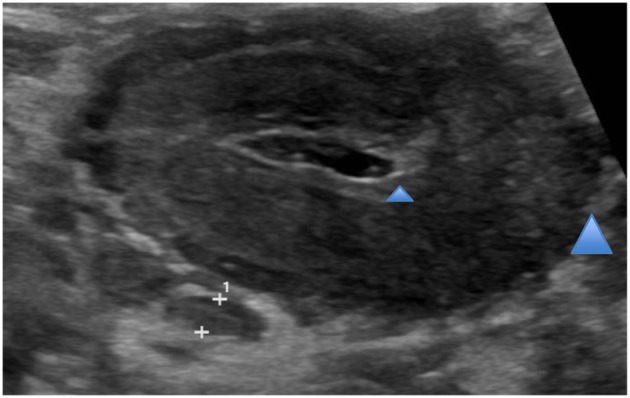
Abdominal ultrasound. Marked thickening of colon loops within mid epigastric and left upper quadrant representing transverse (see blue arrows) and descending colon.